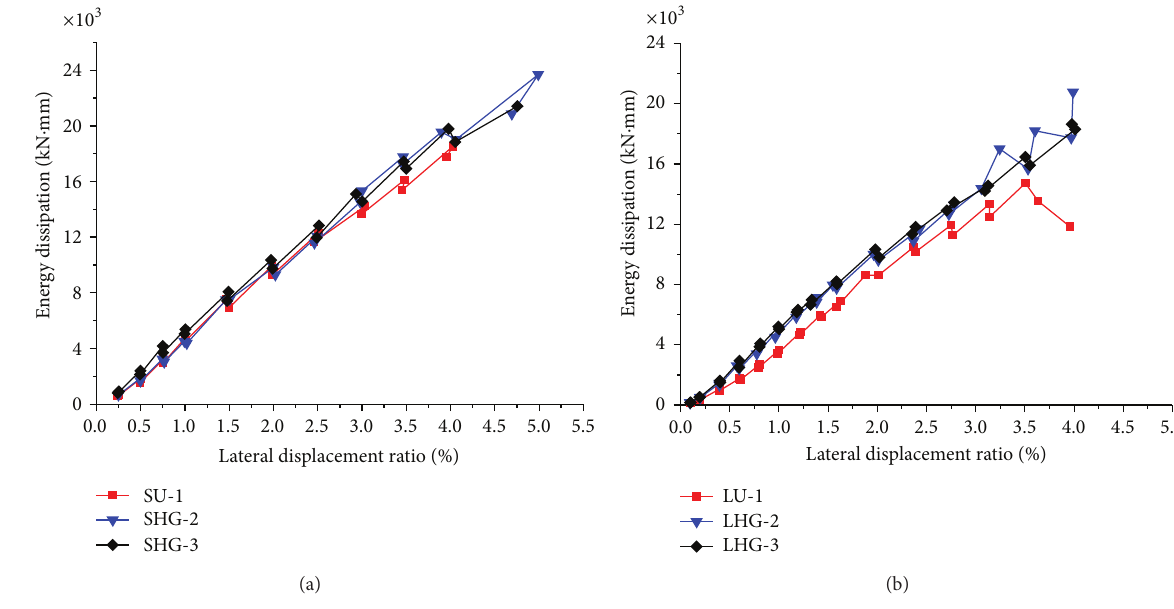
Figure 5: Comparison of energy